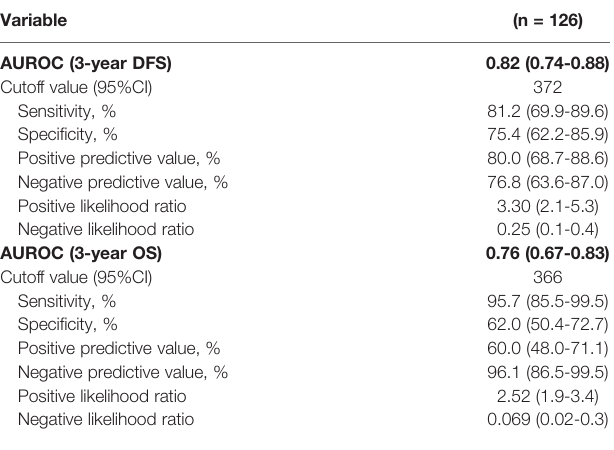
TABLE 2 | The prognostic value of plasma exosome-derived SENP1 in melanoma patients. Variable (n =